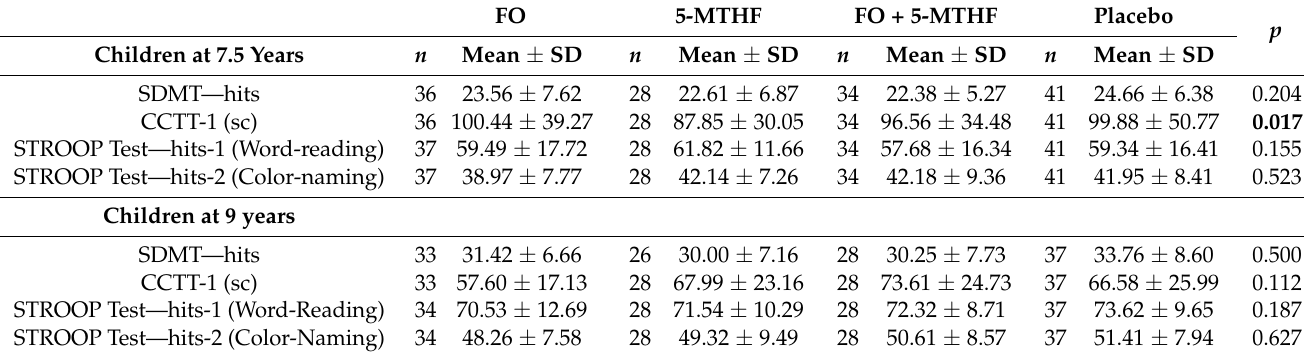
Table 2. Descriptive analysis of processing speed evaluation in the NUHEAL children at 7.5 and 9 years. FO